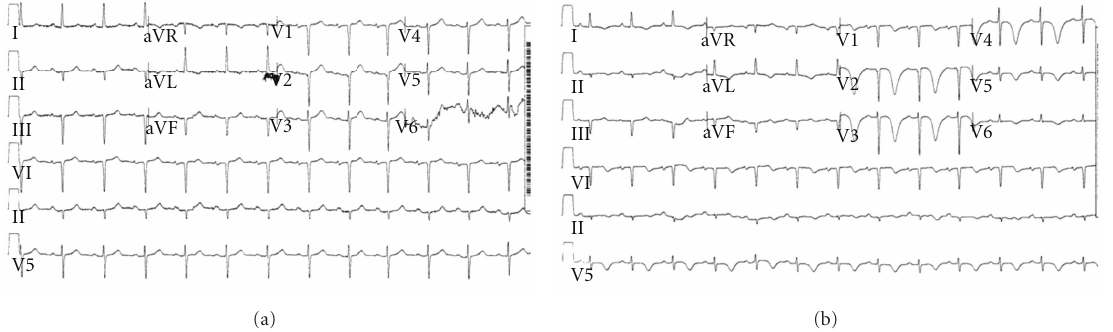
Figure 1: (a) ECG on presentation. (b) ECG performed on the next morning showing symmetrical giant precordial T wave inversion with prolonged QT